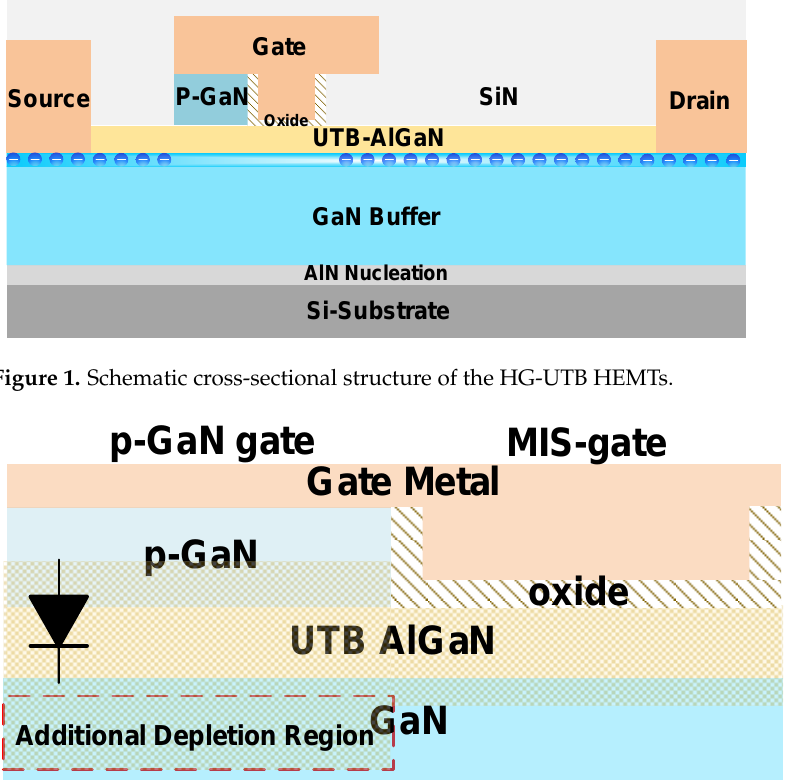
Figure 2. Depletion distribution under the gate region of HG-UTB HEMTs.